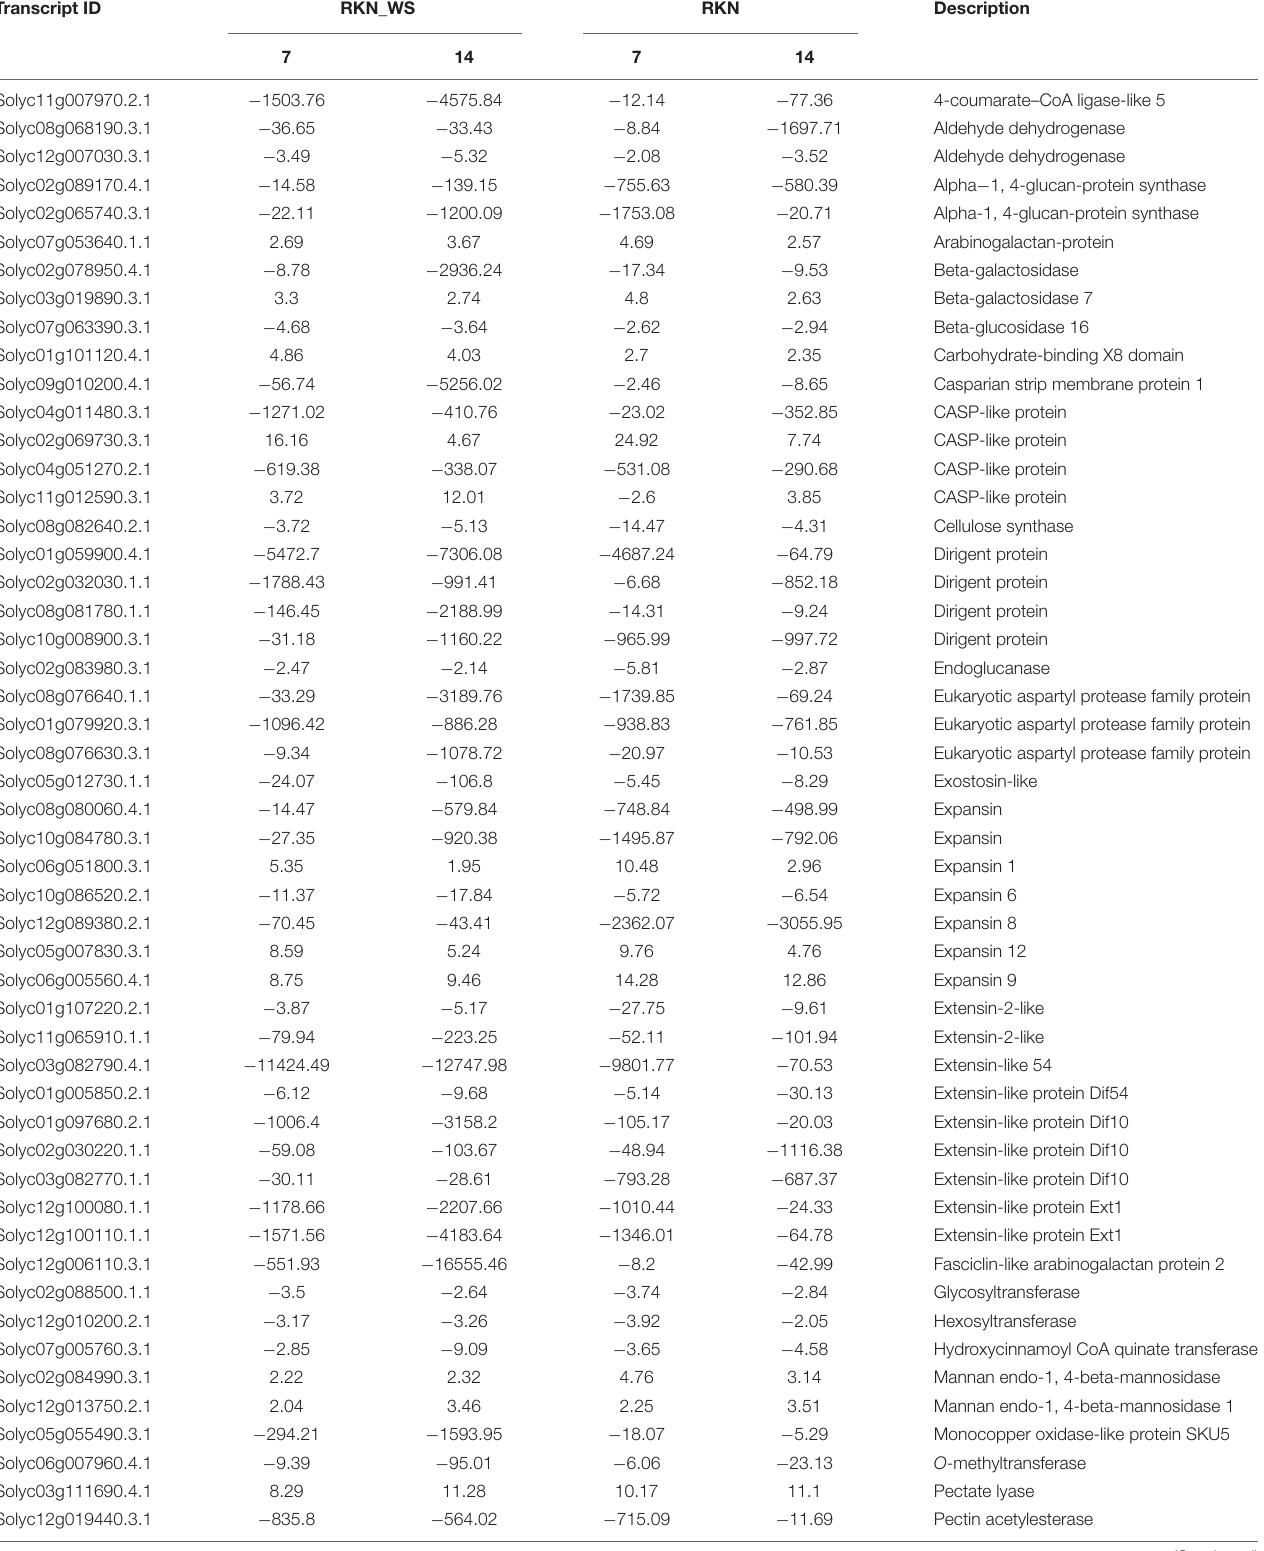
TABLE 3 | DEGs related to the cell wall in common between galls from treatments RKN_WS and RKN at 7 and 14